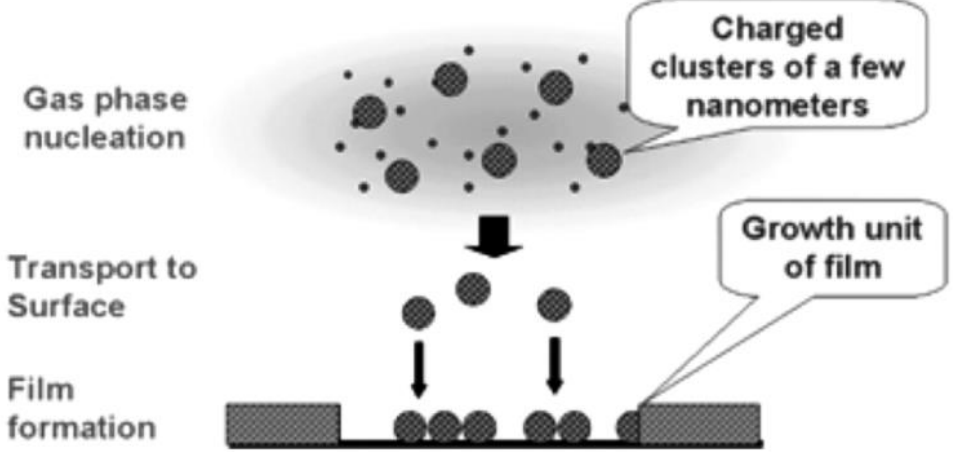
Figure 9. Schematic of the theory of charged clusters in terms of nanocrystal and thin film growth. Reprinted with permission from [82], copyright 2004, Elsevier.